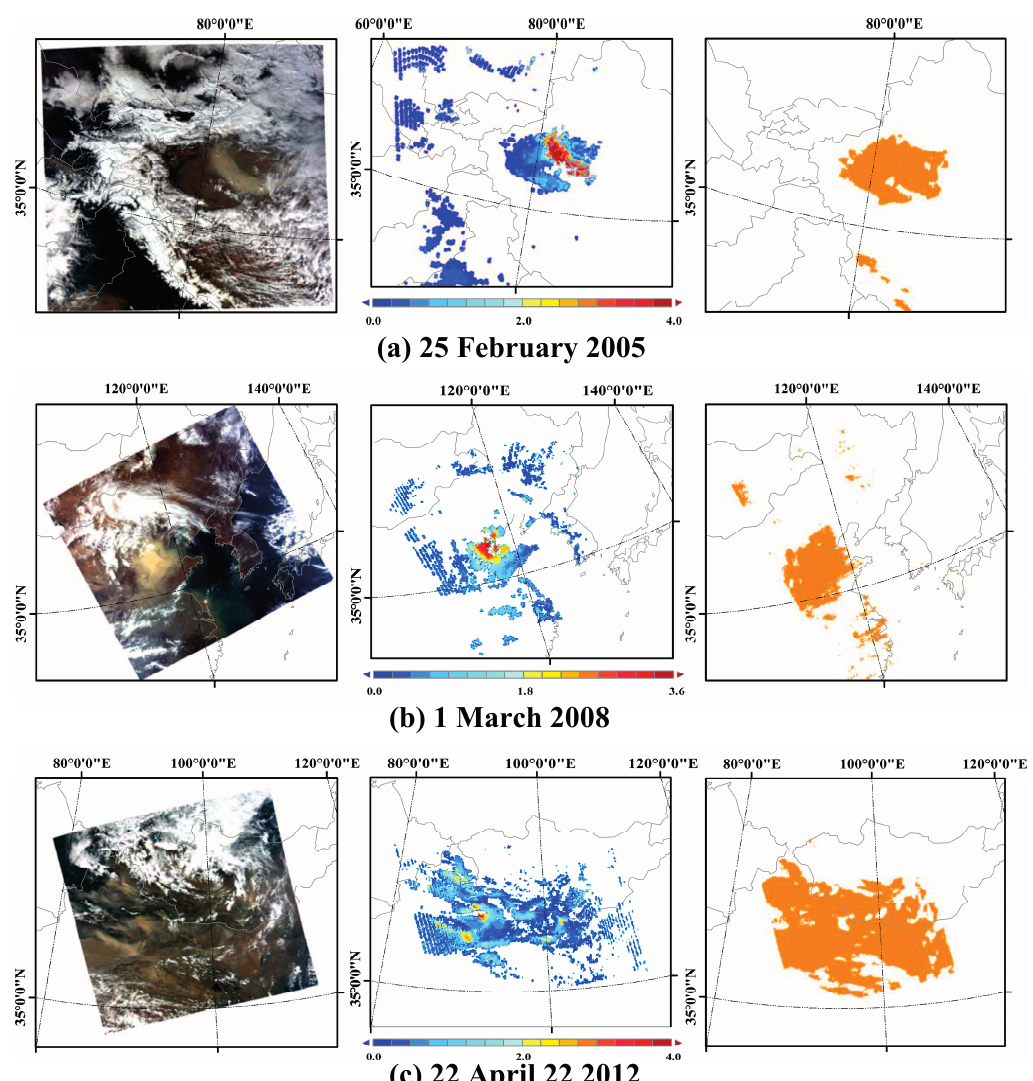
Figure 12. Asia dust events occurred over northern China ( a ) 25 February 2005; ( b ) 1 March 2008; ( c ) 22 April 2012. Images from left to right are MODIS RGB composite image, MODIS deep blue aerosol optical depth and DSSI dust detection result,